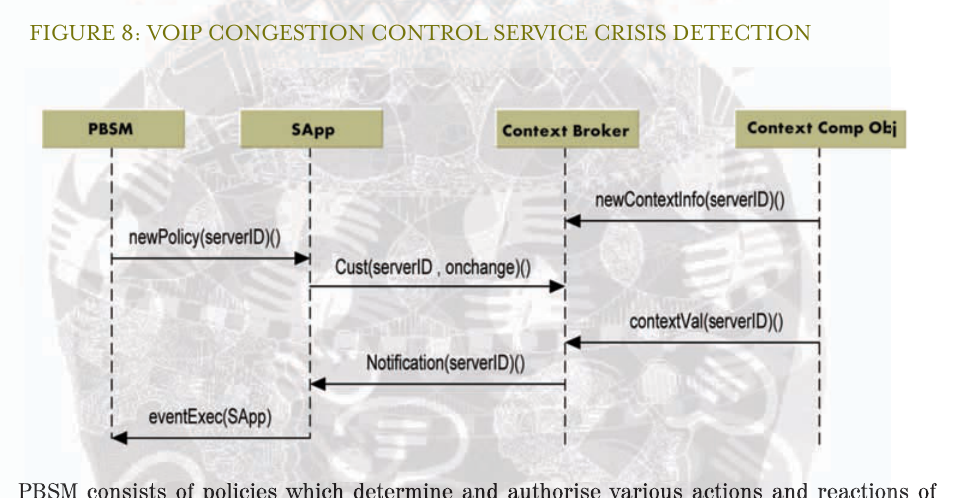
FIGURE 8: VOIP CONGESTION CONTROL SERVICE CRISIS